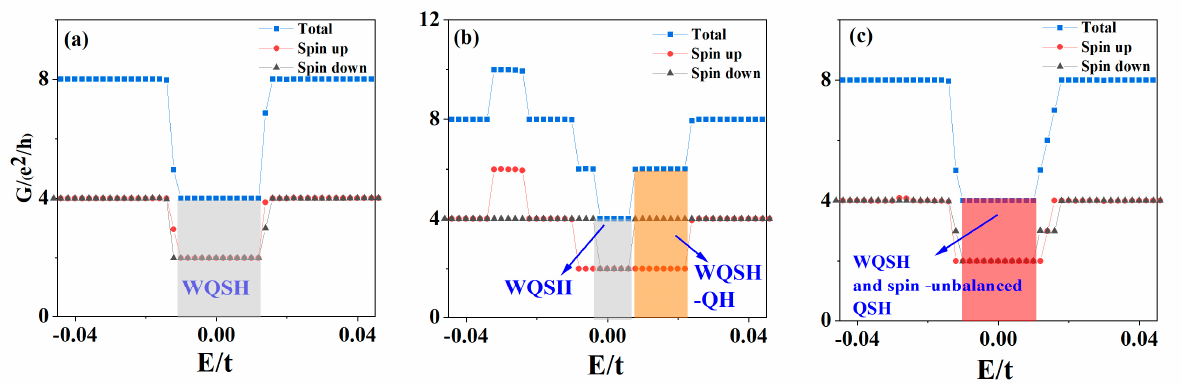
Figure 5. ( a – c ) The two-terminal conductance G as a function of Fermi energy E of Figure 4a–c. At an electric field E = 8.8 × 10 6 V/m, the electric field leads to a band structure and quantized conductance no longer symmetric with respect to zero energy. The spin band gap is obviously smaller than that without an electric field, thus, the total conductance near zero energy is still 4ne 2 /h with n = 1, 2, 3, . . . . However, the total conductance is 6ne 2 /h in the orange region due to the significant spin-polarized edge and interface states. When the local potential V 1 = − V 2 = 0.02t is added, the band structure and quantized conductance are also no longer symmetric with respect to zero energy. Nevertheless, the local potential is only added to the BR and TR, and the spin band gap at zero energy is not fully opened. Part of the spin-up and spin-down energy bands near zero energy are shifted significantly away from zero energy, which leads to the reduction of the conductance at zero energy to 4ne 2 /h. From these results, we can see that the quantized conductance can be controlled by applying an electric field or local